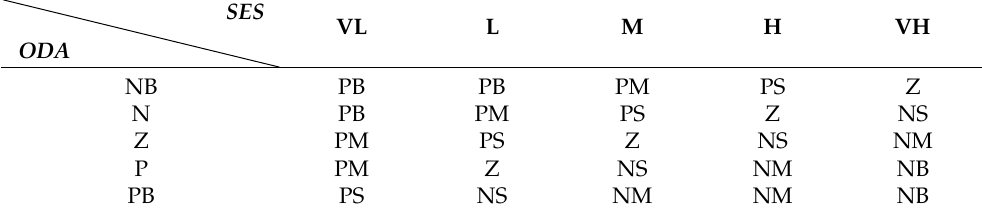
Table 1. The fuzzy rules that were used in the implementation of the